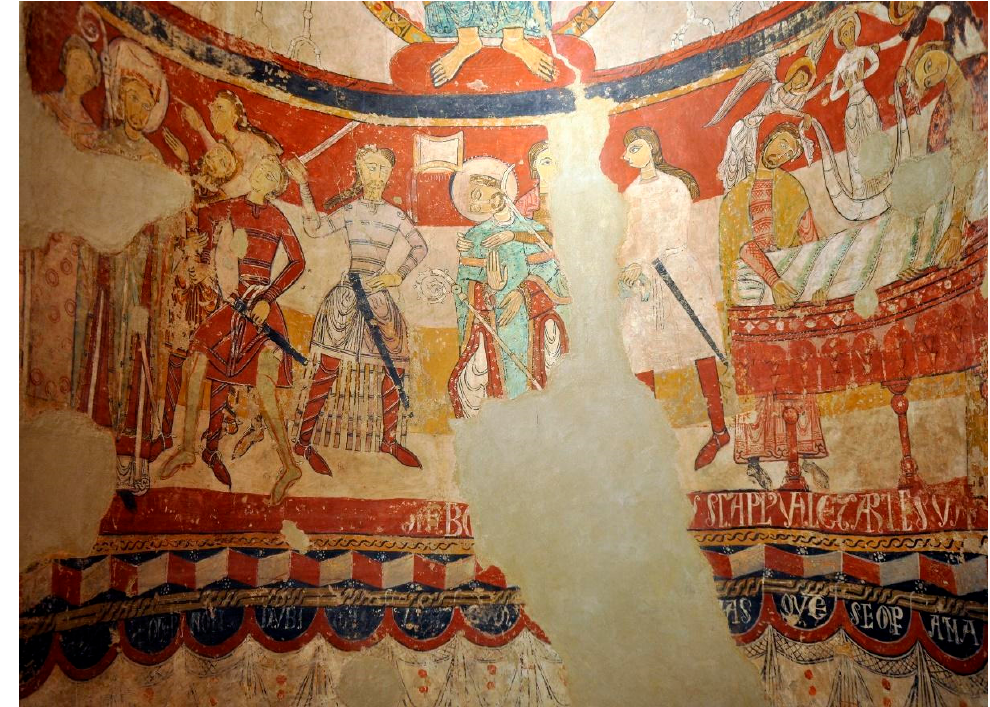
Figure 2. Wall paintings at Santa Maria de Terrassa. Detail of the central segment with the martyrdom. © Photo: Carles Sánchez.